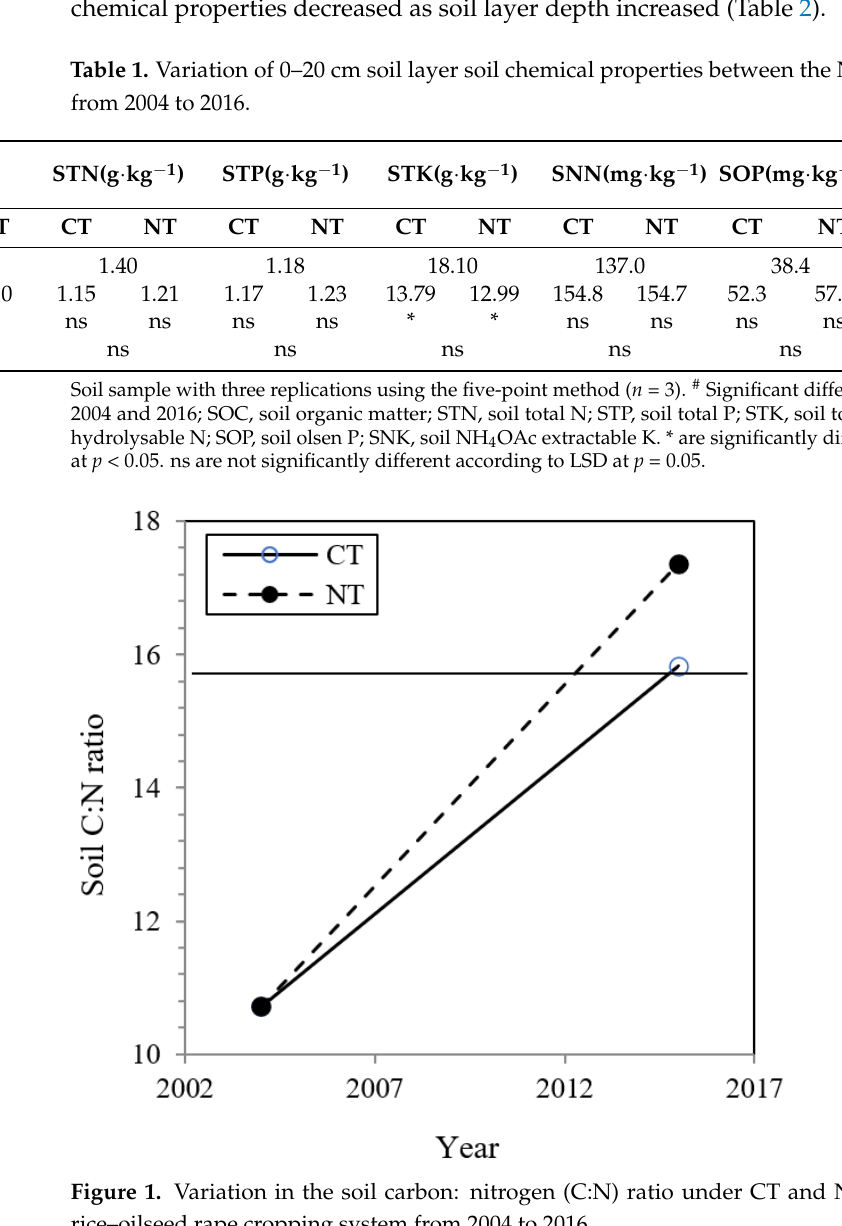
Table 1. Variation of 0 ‐ 20 cm soil layer soil chemical properties between the NT and CT treatment from 2004 to 2016.